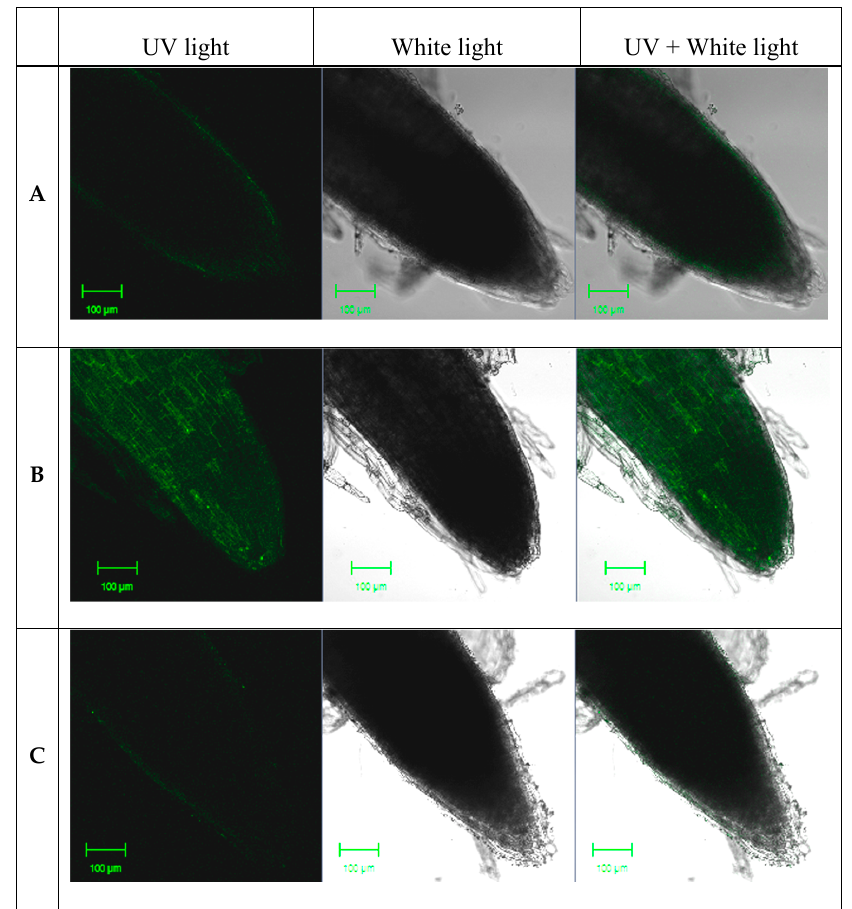
Figure 1. Effect of SNP on nitric oxide (NO) generation in L. olgensis seedlings. NO fluorescence was detected using the NO-specific 4-amino-5-methylamino-2 ′ ,7 ′ -difluorofluorescein diacetate (DAF-FM-DA) green fluorescent dye, and viewed by confocal laser scanning microscopy. ( A ) Root of control seedlings; ( B ) Root of seedlings treated with 167.8 μ M sodium nitroprusside (SNP, NO donor) for 5 h; ( C ) Root of seedlings treated with 167.8 μ M SNP and 100 μ M 2-4-carboxyphenyl)-4,4,5,5-tetramethyl-imidazoline-1-oxyl-3-oxide (cPTIO) for 5 h. For nitrogen metabolism, several DEGs (Table S4) were determined to be involved in nitrate reductase activity (Figure 3A), nitrate transport (Figure 3B), and response to organic nitrogen (Figure 3C). Two NR genes were transcriptionally induced by NO treatment (Figure 3A), which was similar to previous findings involving birch cells in suspension [22]. There is growing evidence that NR is one of the main potential sources of endogenous NO in plants [4]. Therefore, our results support previous findings that exogenous NO is involved in the regulation of endogenous NO signals in larch seedlings. Among the genes with KEGG pathway annotations, 2670 DEGs were identified between the control and SNP libraries. Pathway enrichment analysis showed that 120 pathways were significantly enriched (Q value ≤ 0.05) in DEGs detected between the control and SNP libraries (Table S5). Most DEGs were associated with metabolic pathways (945 members), biosynthesis of secondary metabolites (573 members), ribosome (213 members), and phenylpropanoid biosynthesis (200 members).